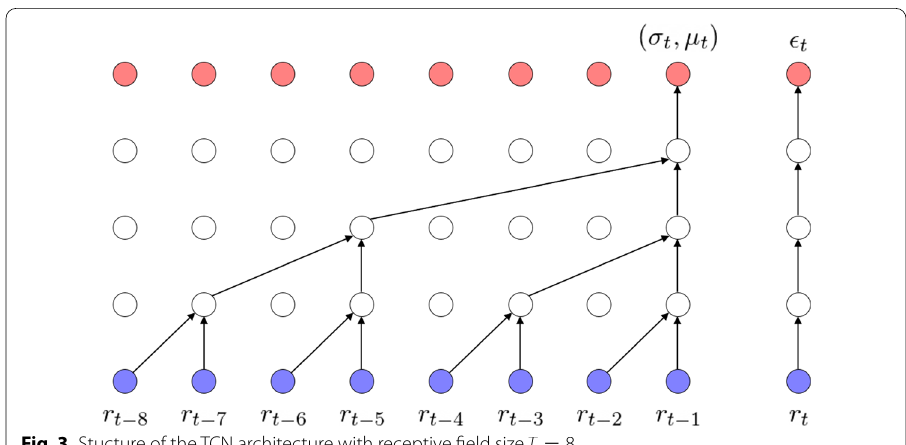
Fig. 3 Stucture of the TCN architecture with receptive field size T =